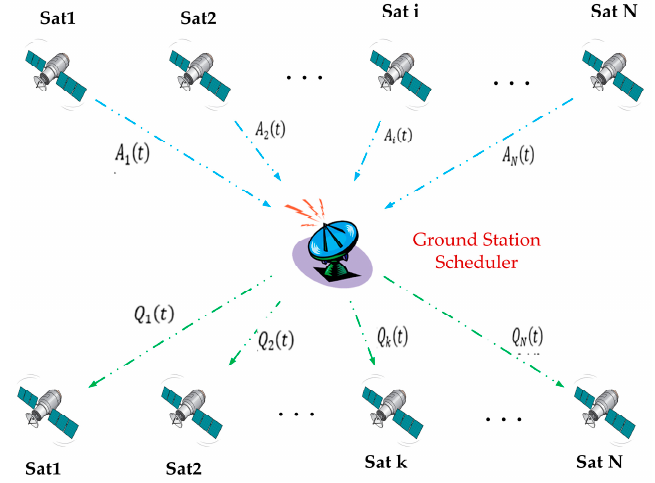
Figure 2. Task O ffl oad Schematic. Figure 2. Task Offload